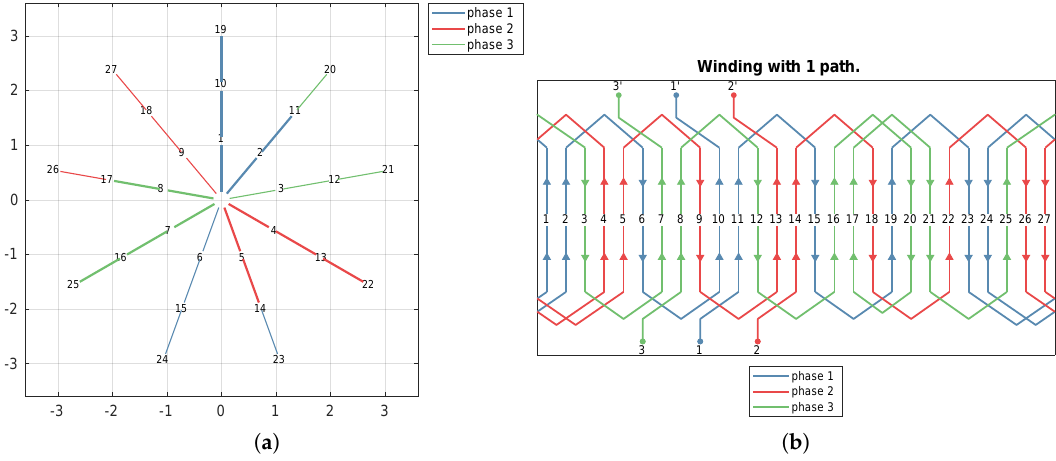
Figure 7. ( a ) Slot EMF star for a symmetrical single-layer bar winding and ( b ) winding scheme. N = 27, m = 3, p = 3 and q = 1 + 1 / 2